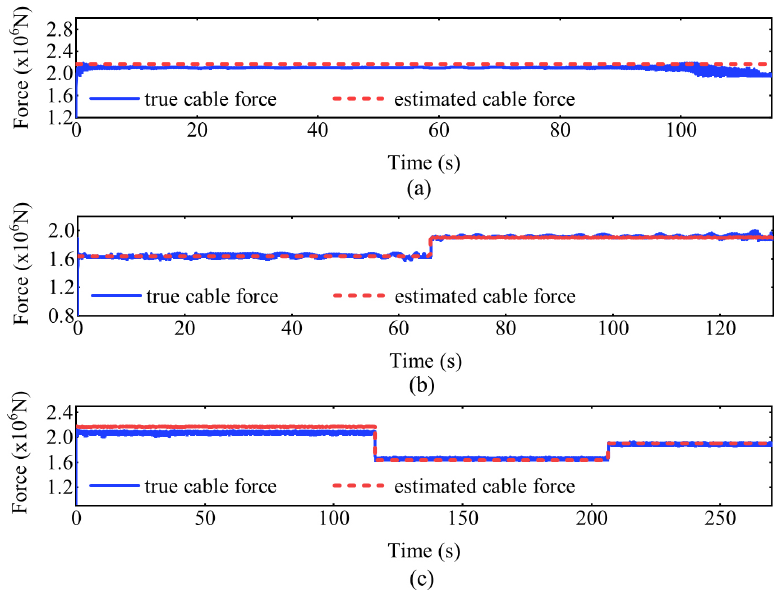
Figure 12. Time-varying cable forces of the full-scale model experiment: ( a ) Condition 1, ( b ) Condition 2, ( c ) Condition 3.